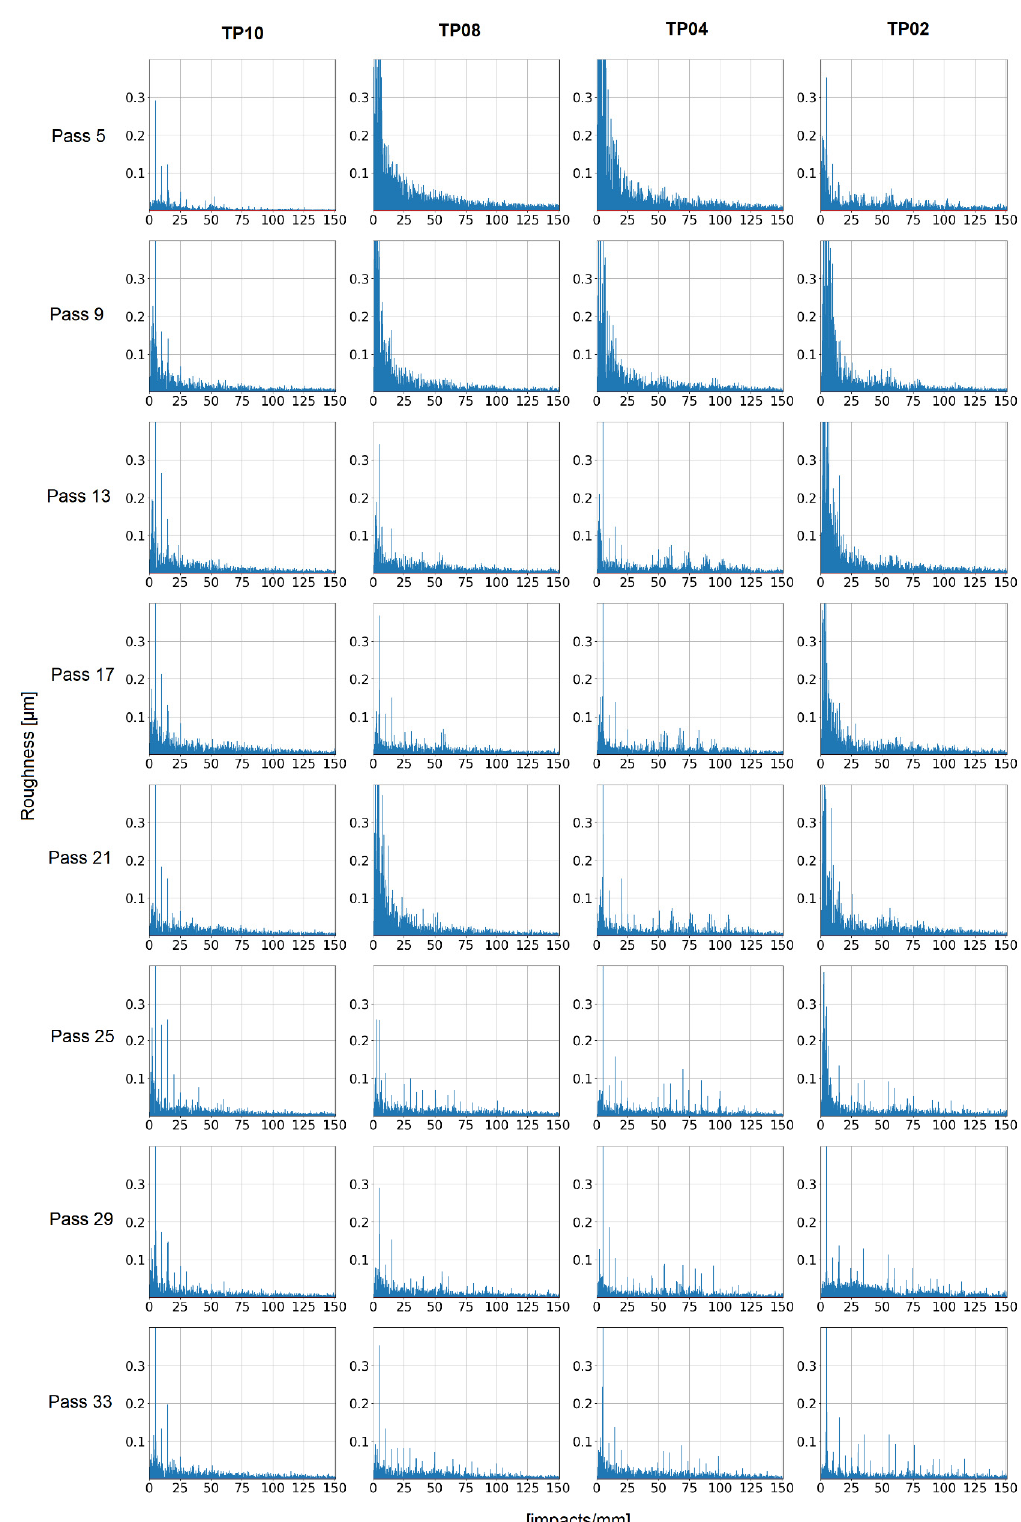
Figure 12. Roughness profile FFT. Surface roughness is the result of the combination of various factors acting simulta- neously, as chatter and deflection, being difficult to discern between them, as L ó pez de Lacalle et al. [35] have pointed out. With the purpose of determining the origins of surface roughness, the roughness model proposed has been applied and its results are shown